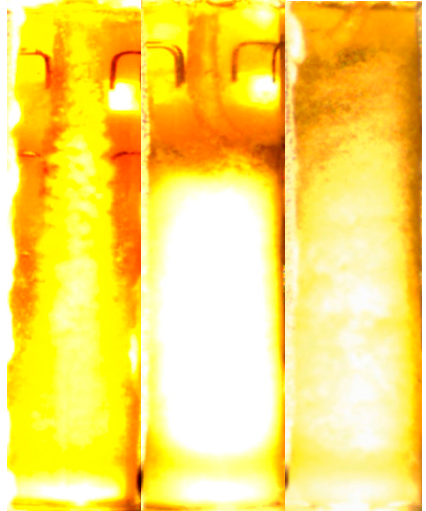
Figure 11. Solidification front images for different geometry of storage units but for the same process time equal to 20 min and the same constant wall temperature condition ( Ts = 17 °C): at left for annular TES, at the middle for shell-and-coil TES with coil position at the bottom of the tank, at the right for shell-and-coil TES with coil position at upper of the tank.